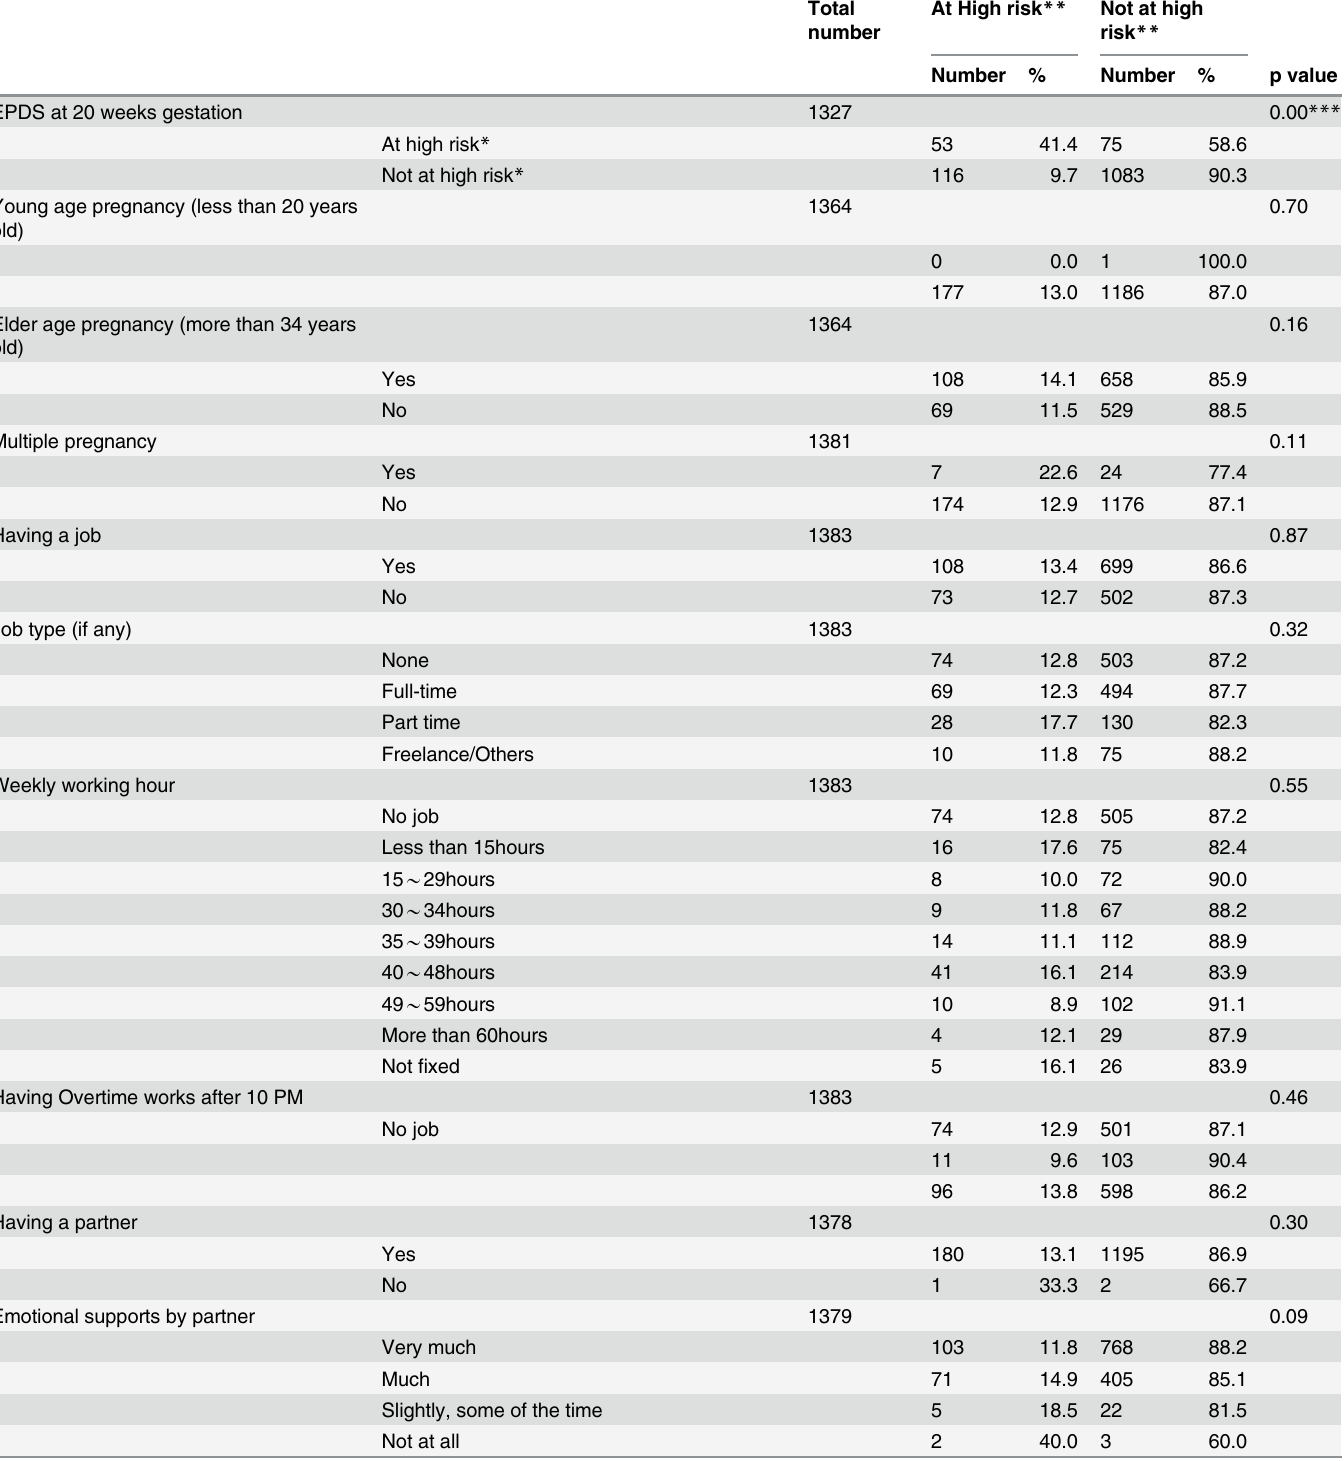
Table 2. The results of the bivariate tests of the factors at 20 weeks gestation with the mental health risk in the Edinburgh Postpartum Depression Scale at one month postpartum). Total At High risk ** Not at high number risk ** Number % Number % p value EPDS at 20 weeks gestation 1327 0.00 *** At high risk * 53 41.4 75 58.6 Not at high risk * 116 9.7 1083